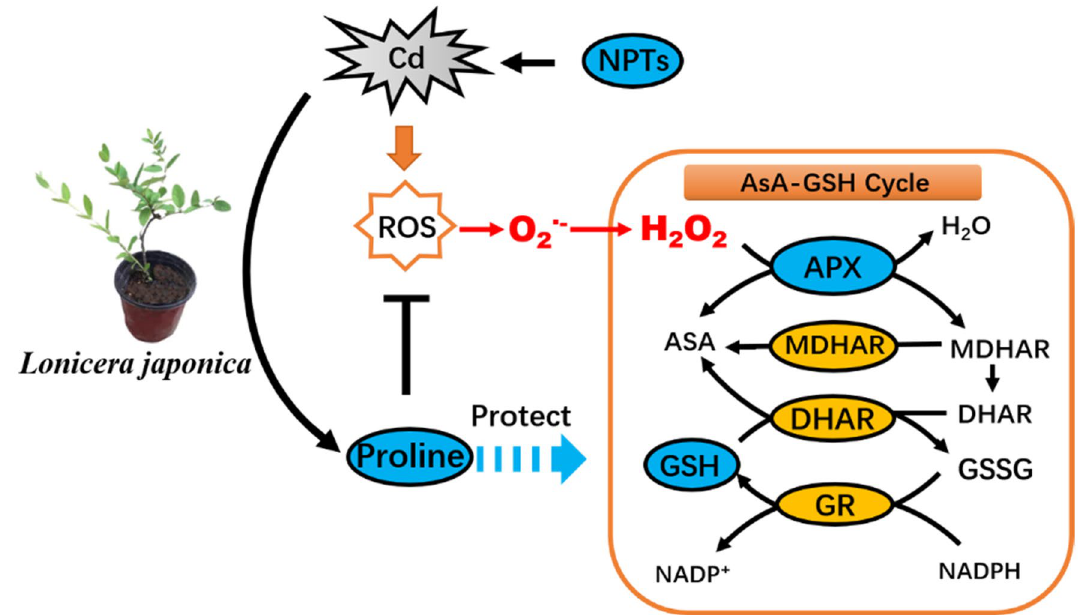
Figure 7. The antioxidant defense response in Lonicera japonica to Cd-induced oxidative